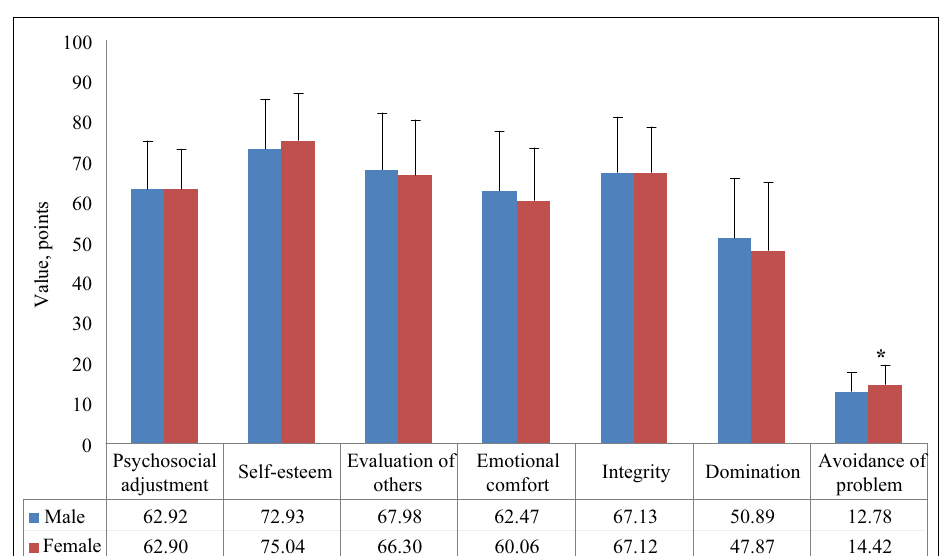
Figure 1. Levels of boys’ and girls’ psychosocial adjustment and its components